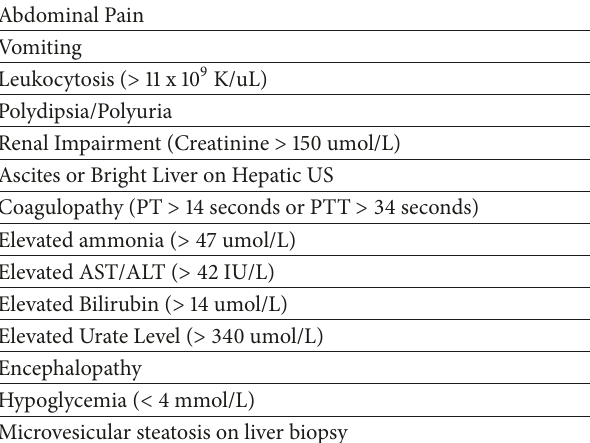
Table 1: Swansea Criteria for AFLP